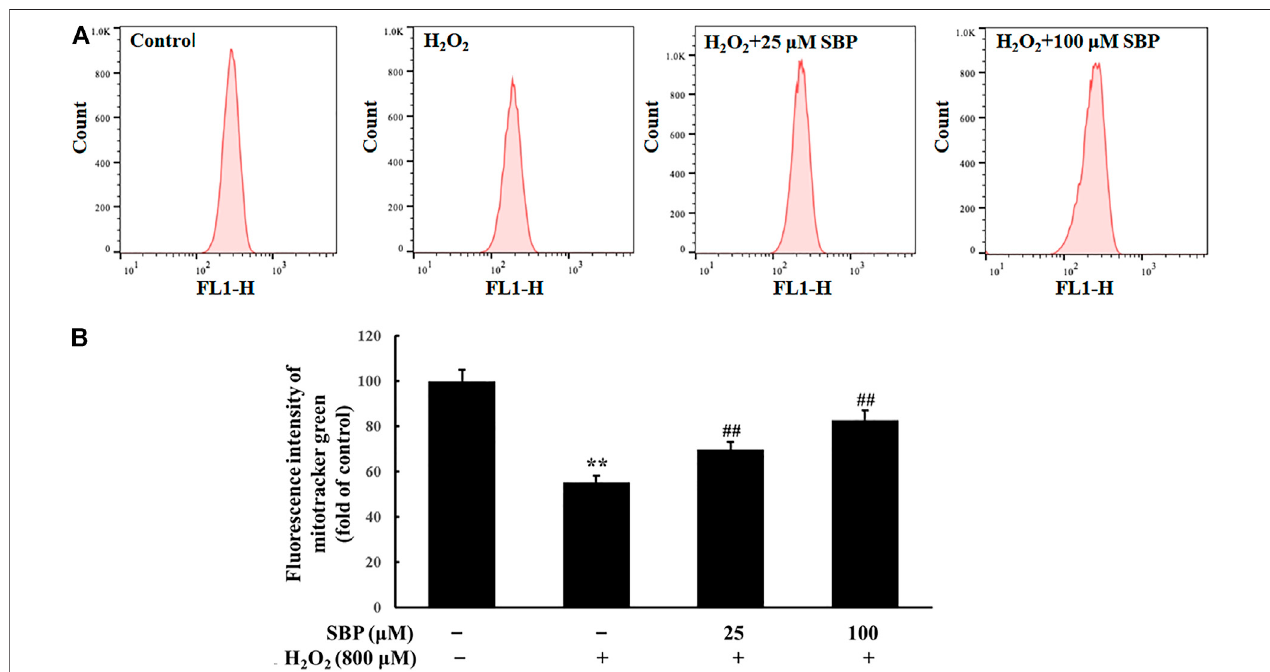
FIGURE 4 | Effect of SBP on the mitochondrial mass in RAW 264.7 cells. (A) Representative fl ow cytometric histograms of each group. (B) The relative fl uorescenceintensitiesofRAW264.7cellstreatedwithMito-Trackergreen.** p < 0.01comparedtothecontrolgroup;## p < 0.01comparedtotheH